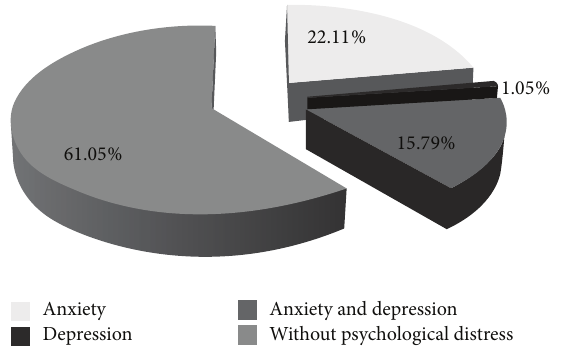
Figure 1: Prevalence of anxiety or depression in the population included in the